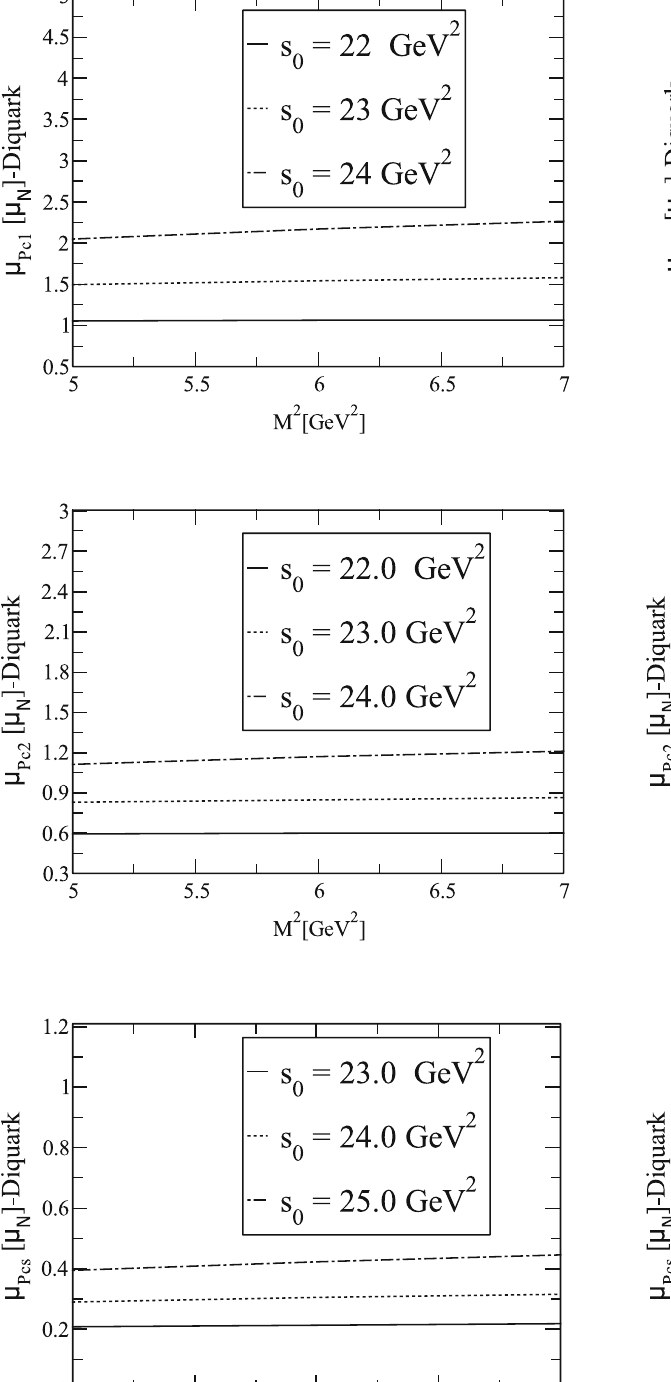
, μ P and μ P in diquark–diquark–antiquark picture with M 2 and s 0 cs c 1 c 2 phy of the method used, the observables under examination should be weakly dependent on the variations of these